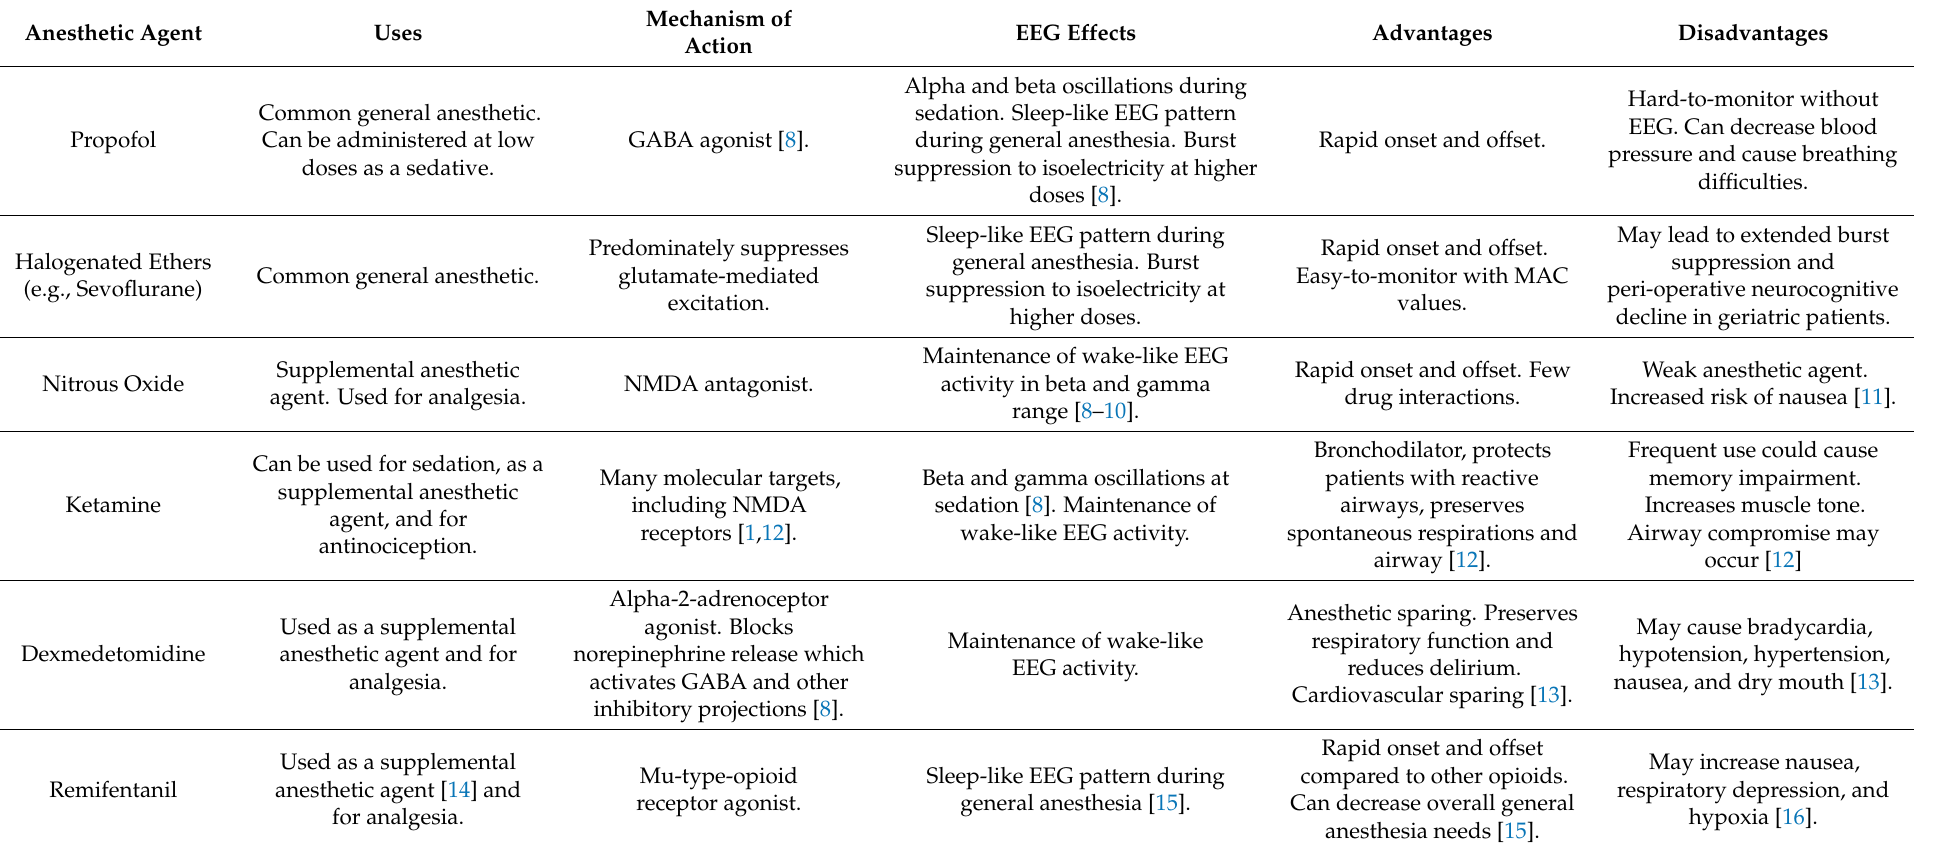
Table 1. Summary of uses, mechanisms of action, electroencephalogram (EEG) effects, advantages, and disadvantages of all anesthetic agents mentioned in this